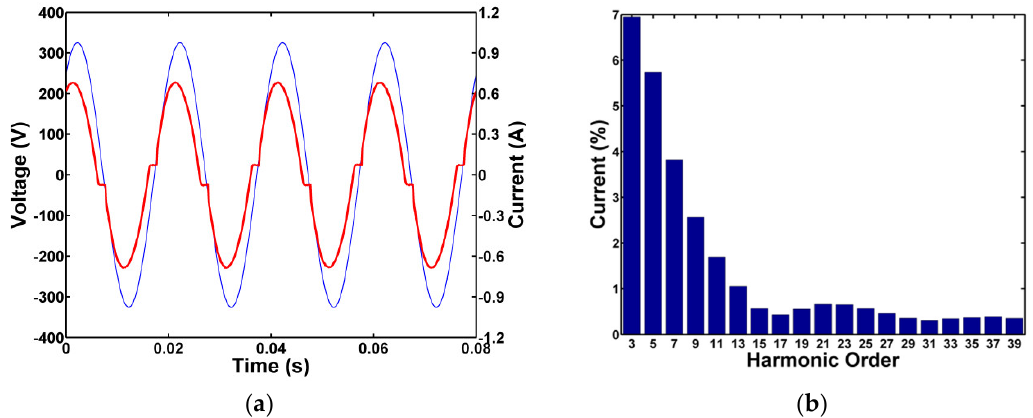
Figure 3. Waveforms of instantaneous values of current and voltage ( a ) for luminaire marked as LUM1 and ( b ) current harmonic spectrum.